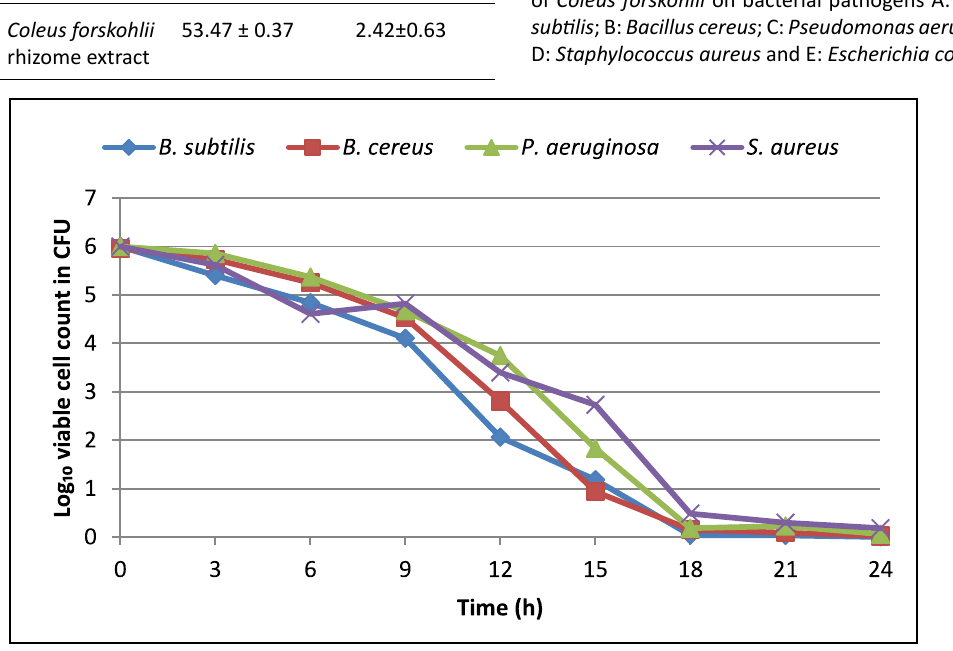
Fig. 2. Time-kill assay for tested bacterial